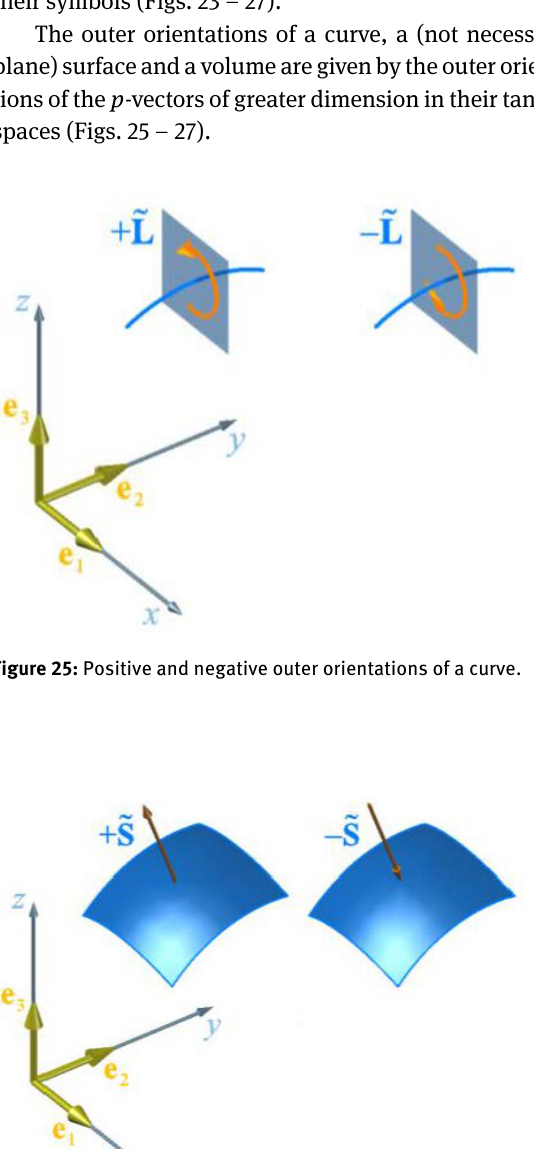
Scalar magnetic potential and stream function in fluid with points with outer